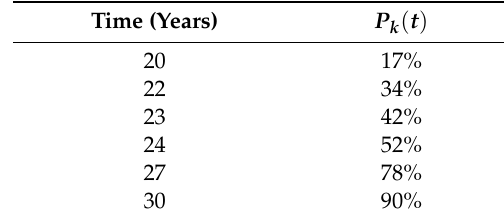
Table 6. Probability of corrosion initiation ( P k ( t )) predicted at di ff erent times measured from t 0 (predictions at t insp = 8 years